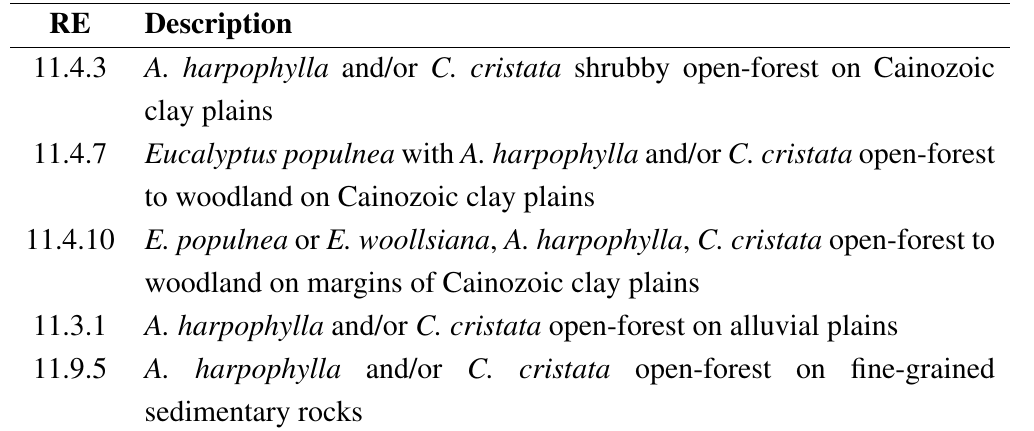
Table 1. Description of Regional Ecosystems (REs) for which field data were available